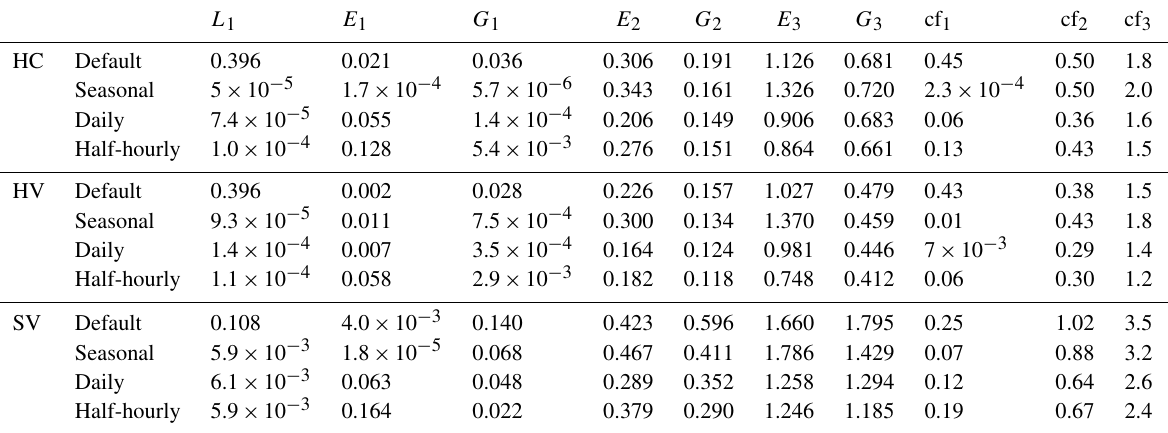
Table 5. Cost function components for each parametrisation for Hyytiälä calibration (HC), Hyytiälä validation (HV) and Sodankylä valida- tion (SV) periods. L 1 , E 1 and G 1 are the LAI, ET and GPP components in cost function (Eq. 1), represented by cf 1 and used for seasonal tuning. Likewise E 2 and G 2 are the components in cost function (Eq. 2) for daily values (cf 2 ), whereas E 3 and G 3 are for half-hourly values (cf 3 ). Note that the values of cf 2 and cf 3 are not directly